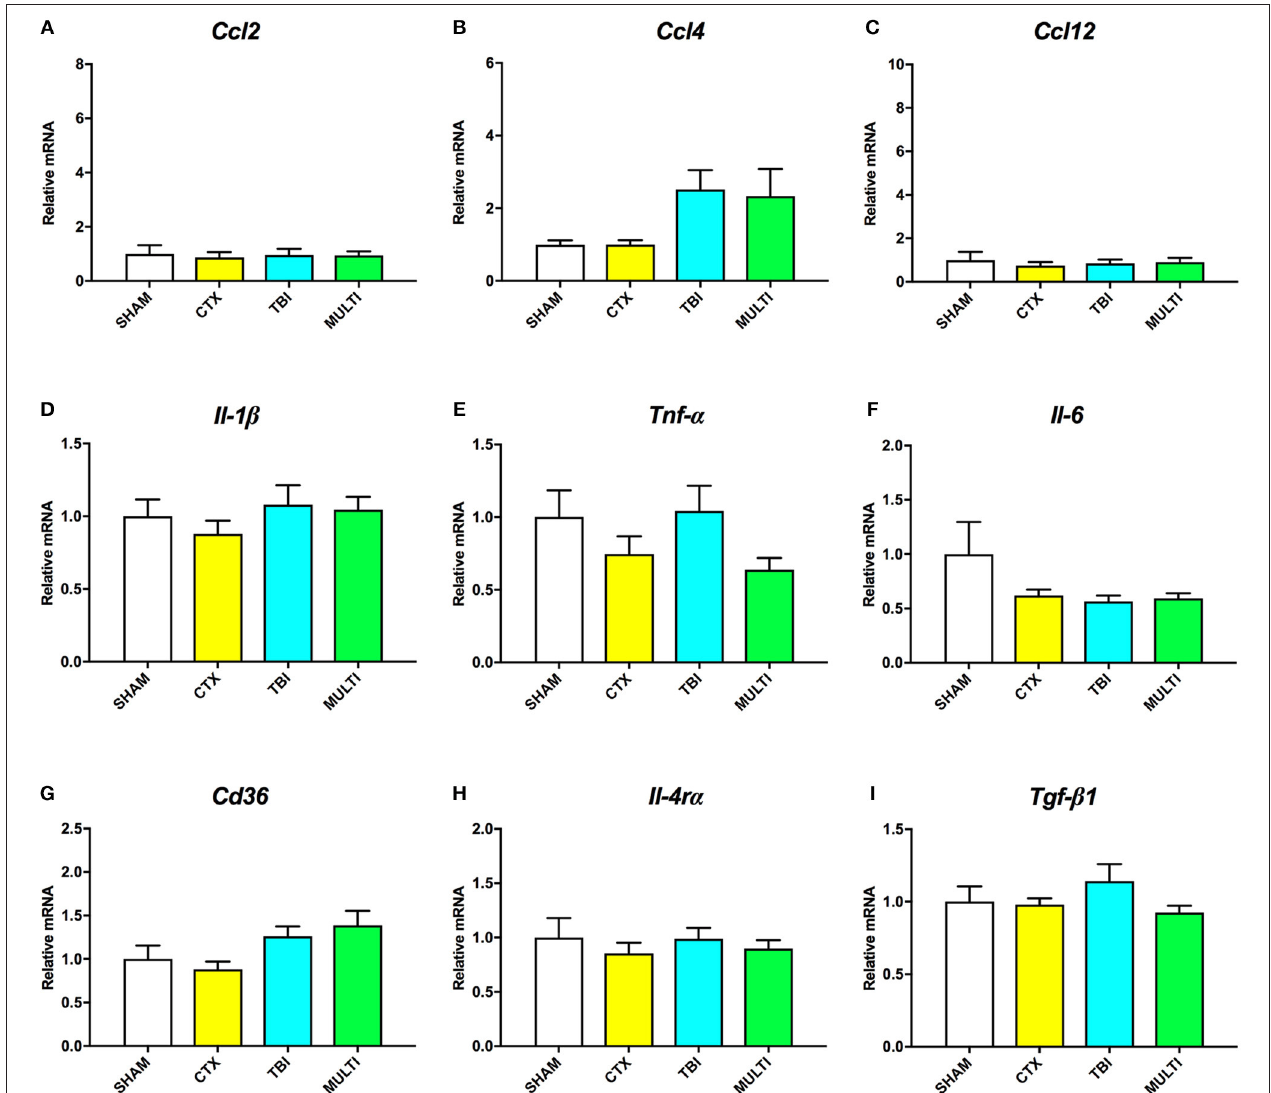
FIGURE 5 | mRNA levels of pro- (A–F) and anti-inflammatory (G–I) cytokines in the ipsilateral cortex at 35 days post-injury. There was a significant effect of injury on Ccl4 (B) and Cd36 (G) . Although TBI and MULTI groups appeared to have similarly elevated levels of Ccl4 and Cd36 , post-hoc analyses did not reach statistical significance after Bonferroni corrections. There were no significant differences on mRNA levels of Ccl2 (A) , Ccl12 (C) , Il-1 β (D) , Tnf- α (E) , Il-6 (F) , Il-4r α (H) , or Tgf- β 1 (I) .